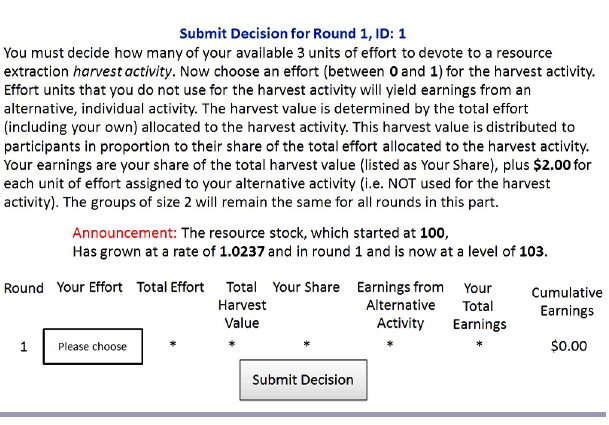
Fig. 9 . A screenshot of the web-based VeconLab experiment. In this example, a public good game is played.